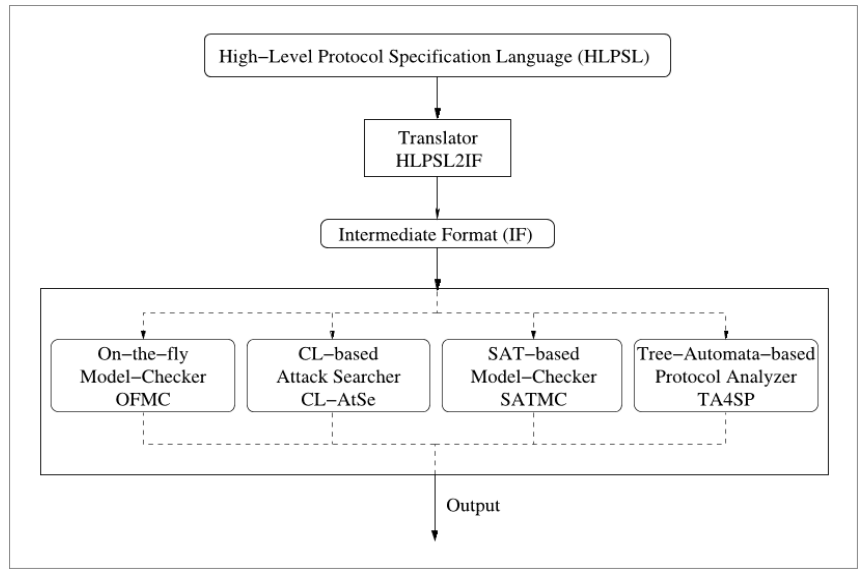
Figure 3. AVISPA